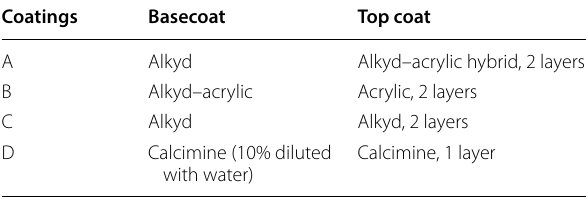
Table 2 Description of the four coating